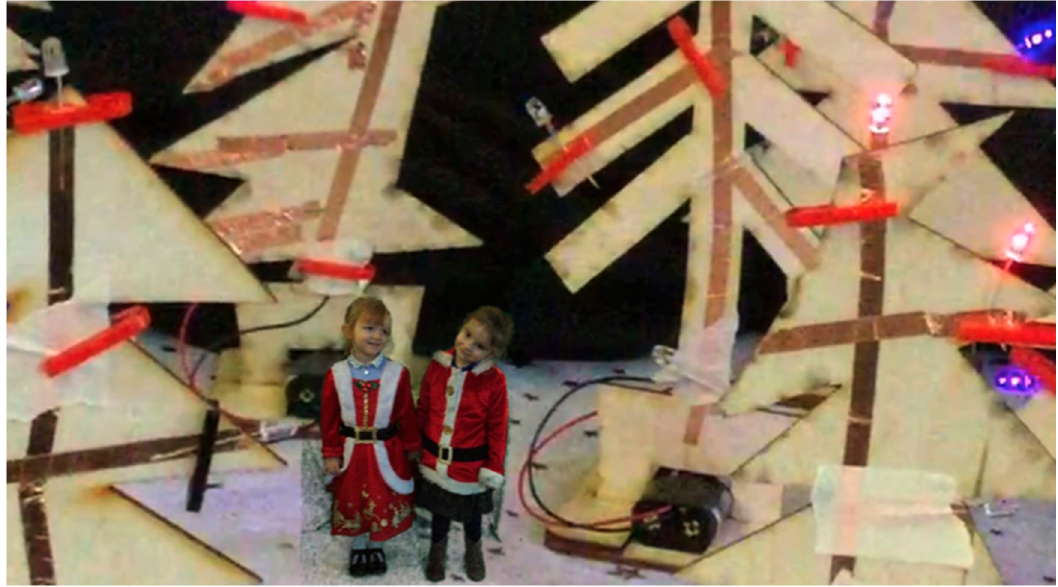
Figure 7. Still from a film using green screen, in which children walked through their Christmas tree forest, singing Christmas songs.